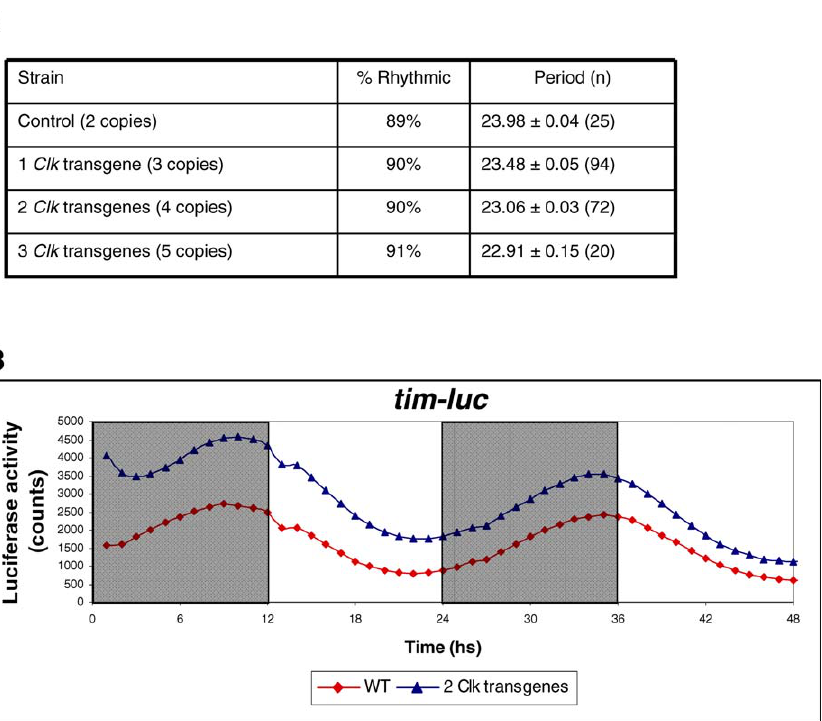
Figure 5. Increase of Clk Copy Number Shortens the Circadian Clock (A) Behavioral analysis of fly strains with one, two, or three doses of a Clk transgene. Transgenes in the second and third chromosome were used. All of the flies assayed are wild type for the endogenous Clk locus. (B) Luciferase recordings from control (yw) and flies carrying two doses of a Clk transgene utilizing the tim - luc reporter. Light timing is indicated by alternating white and gray background areas, with white representing the illuminated interval of the LD condition (ZT0–12) and gray representing the dark period (ZT12–24). The results are the average of 13 (two copies of the Clk transgene) and 18 (control) pairs of fly wings.